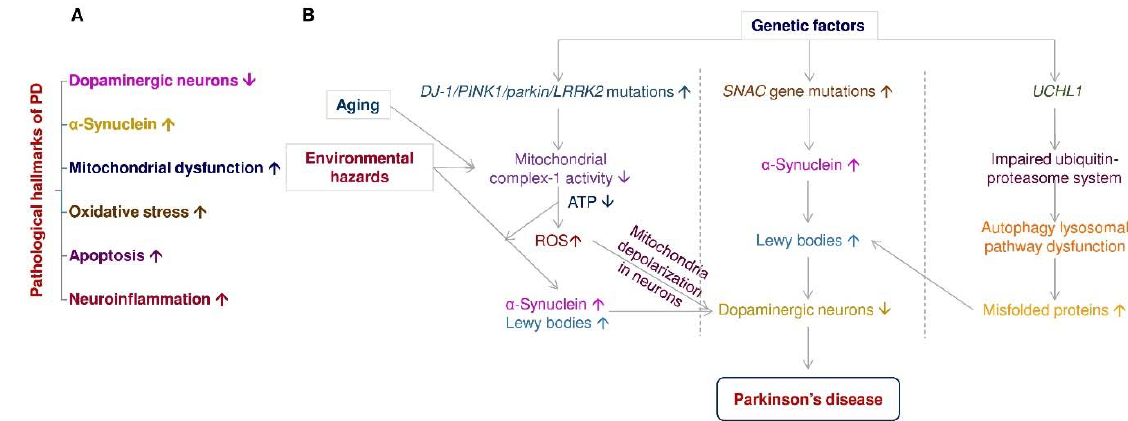
Figure 1. The pathological hallmarks of PD and the interplay of aging, environmental hazards, and genetics in the pathogenesis of PD. ( A ) The pathological hallmarks of Parkinson’s disease include dopaminergic neuronal death, α -synuclein aggregates, mitochondrial dysfunction, reactive oxygen species, apoptosis, and neuroinflammation. ( B ) PD is a multifactorial disorder involving aging, genetics, and environmental factors, associated with dopaminergic neuronal death. Gene mutations associate with PD includes DJ-1 , PTEN-induced putative kinase-1 ( PINK1 ), parkin , leucine-rich repeat serine/threonine kinase-2 ( LRRK2 ), Synuclein alpha ( SNAC ), and ubiquitin carboxyl-terminal hydrolase-L1 ( UCHL1 ). Neurotoxins (e.g., rotenone, paraquat) and gene mutations of DJ-1 , PINK1 , parkin , LRRK2 , and SNAC induce mitochondria complex I inhibition, ATP depletion, reactive oxygen species (ROS) accumulation, mitochondria depolarization, and mitochondrial dysfunction in dopaminergic neurons to promote neuronal death in the substantia nigra of PD patients. Overexpression of SNAC gene mutations enhance α -synuclein aggregation in Lewy bodies of PD brain. UCHL1 gene mutations impair ubiquitin-proteasome systems and further induce autophagy lysosomal pathway dysfunction, contributing to Lewy body formation in dopaminergic neurons.